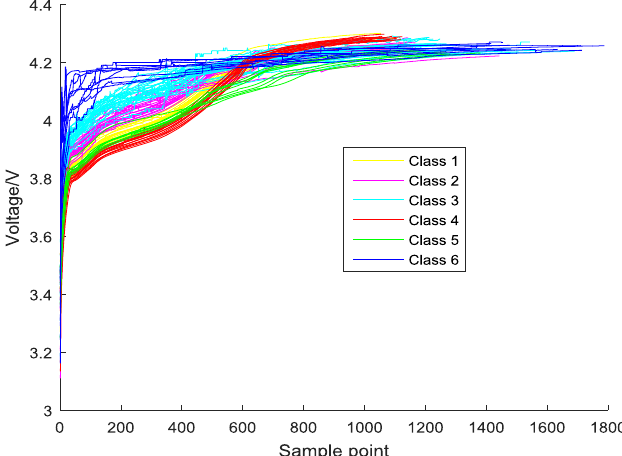
Figure 7. Clustering result for the charge curves with the proposed method.